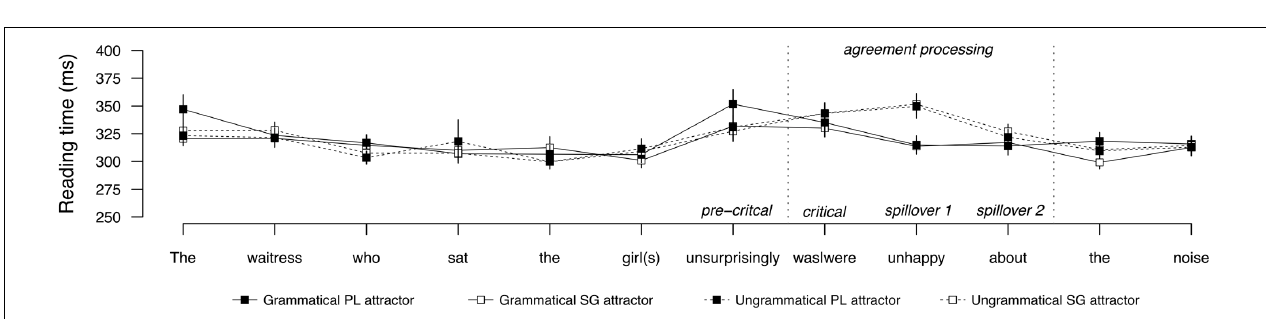
FIGURE 2 | Word-by-word reading times for the direct object attractor conditions in Experiment 1. Error bars indicate standard error of the mean.